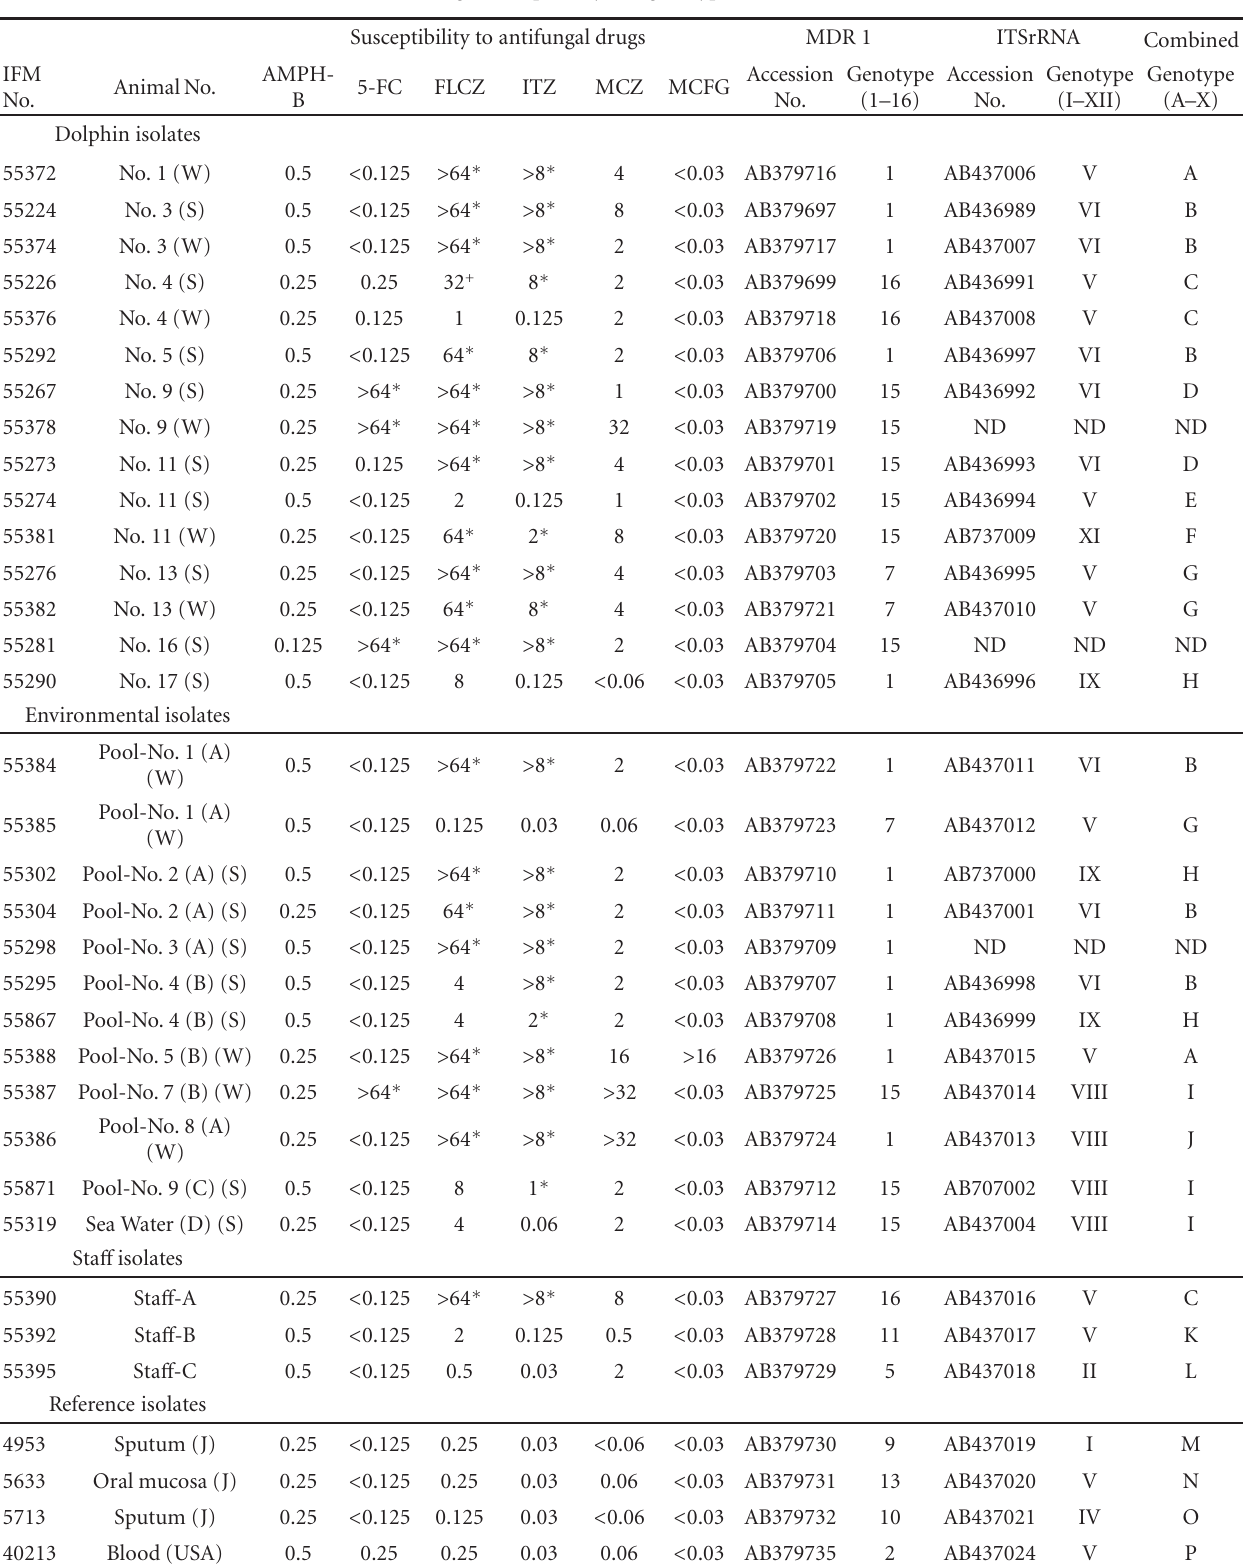
Table 5: Antifungal susceptibility and genotypes of C. albicans